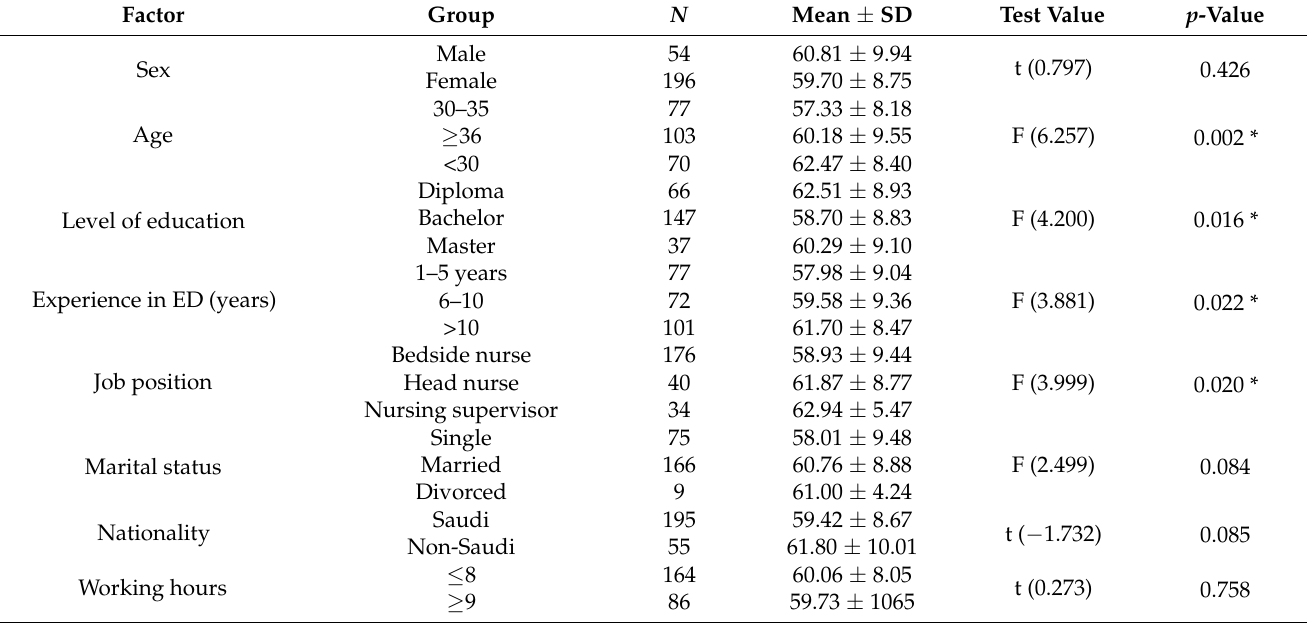
Table 4. Factors affecting nurses’ perceptions of quality of nurse–physician communication in emergency